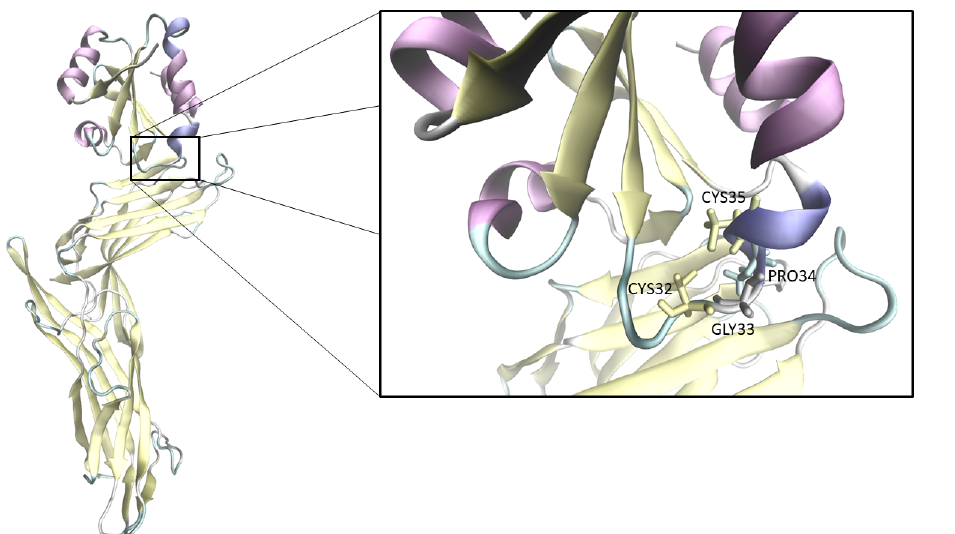
Figure 1. Structure of the complex TRX-TXNIP with a focus on the active site with its CXXC